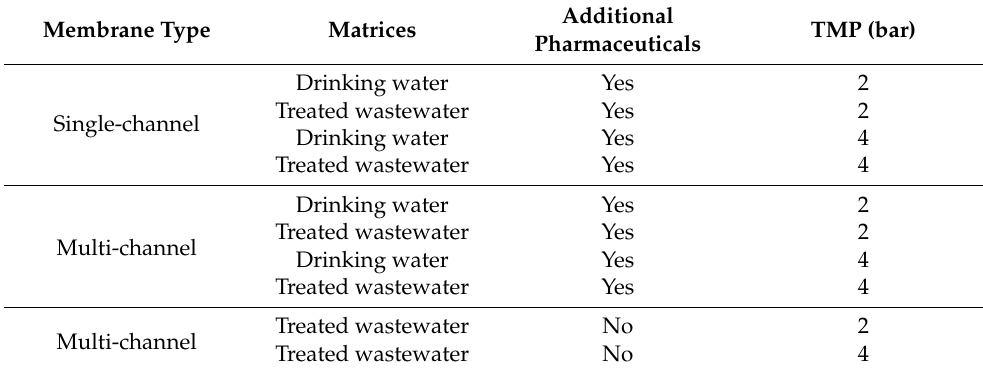
Table 3. Summary of operational parameters of the different